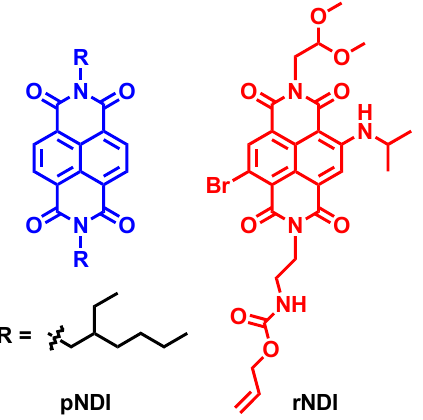
Figure 22. Molecular structures of the NDI compounds rNDI and pNDI.